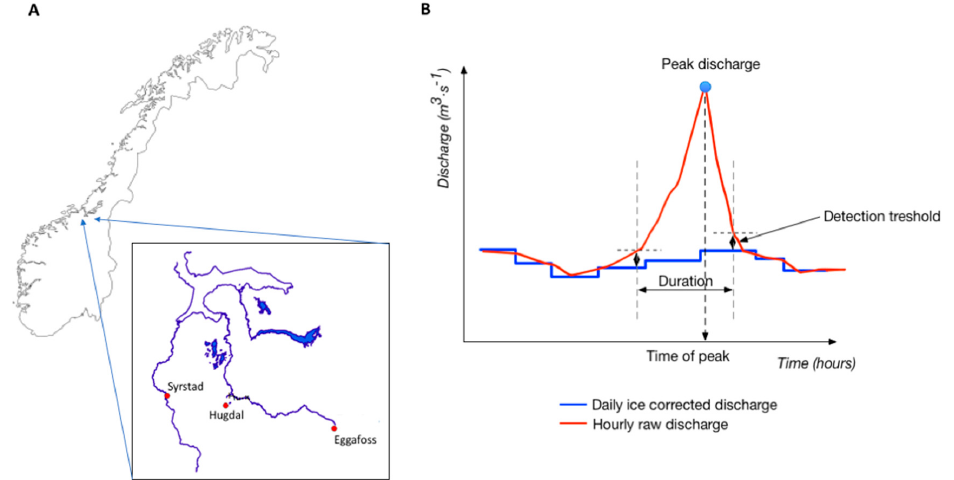
Figure 1. Study sites (panel ( A )), and the principle of detecting ice-induced peaks and their characteristic features from a combination of a daily ice-reduced series (blue) and a raw data series (red) (panel ( B )). For each year, the maximum peak level and the time of the maximum peak are derived from all yearly events. The detection threshold marked on the figure eliminates effects of small fluctuations on the detected peaks. This is a schematic figure only; therefore, there are no values on the